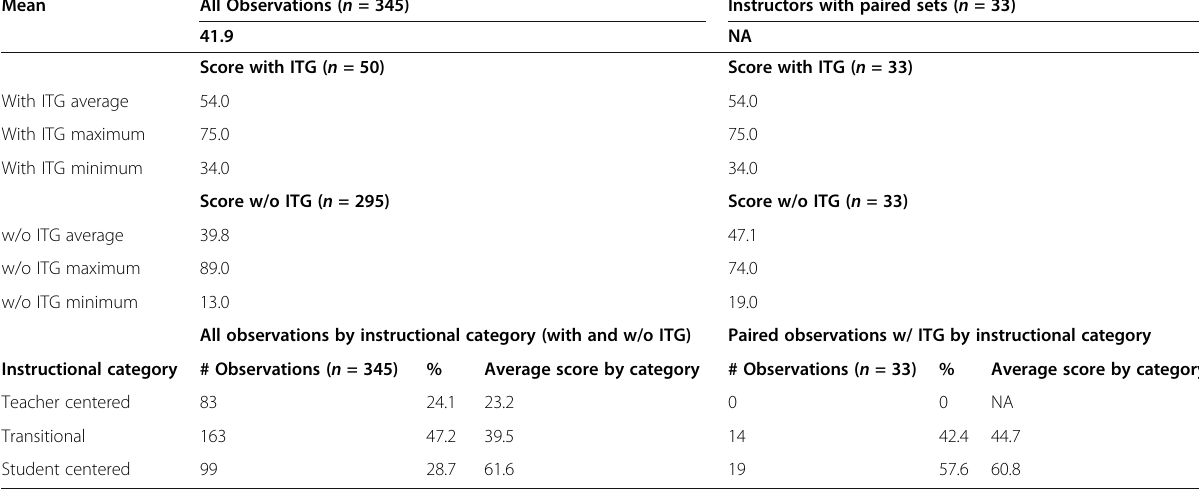
Table 4 Summary of RTOP observation scores for all observations and for the subsets of ITG and non-ITG observations Mean